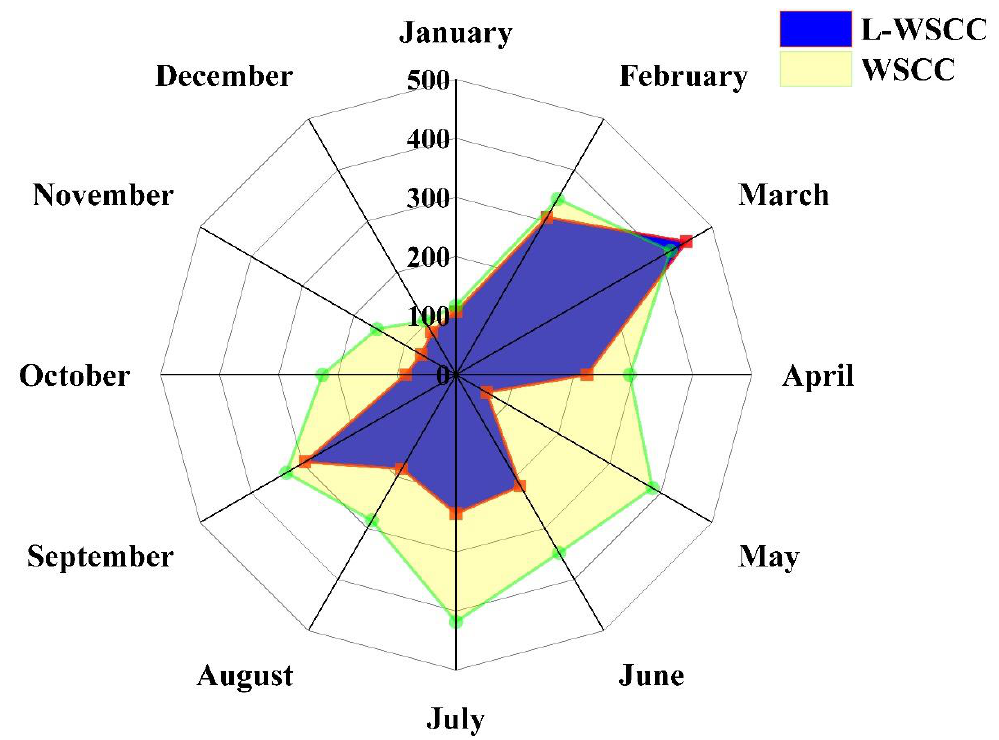
Figure 5. Mean absolute error (MAE) of monthly simulated discharge.